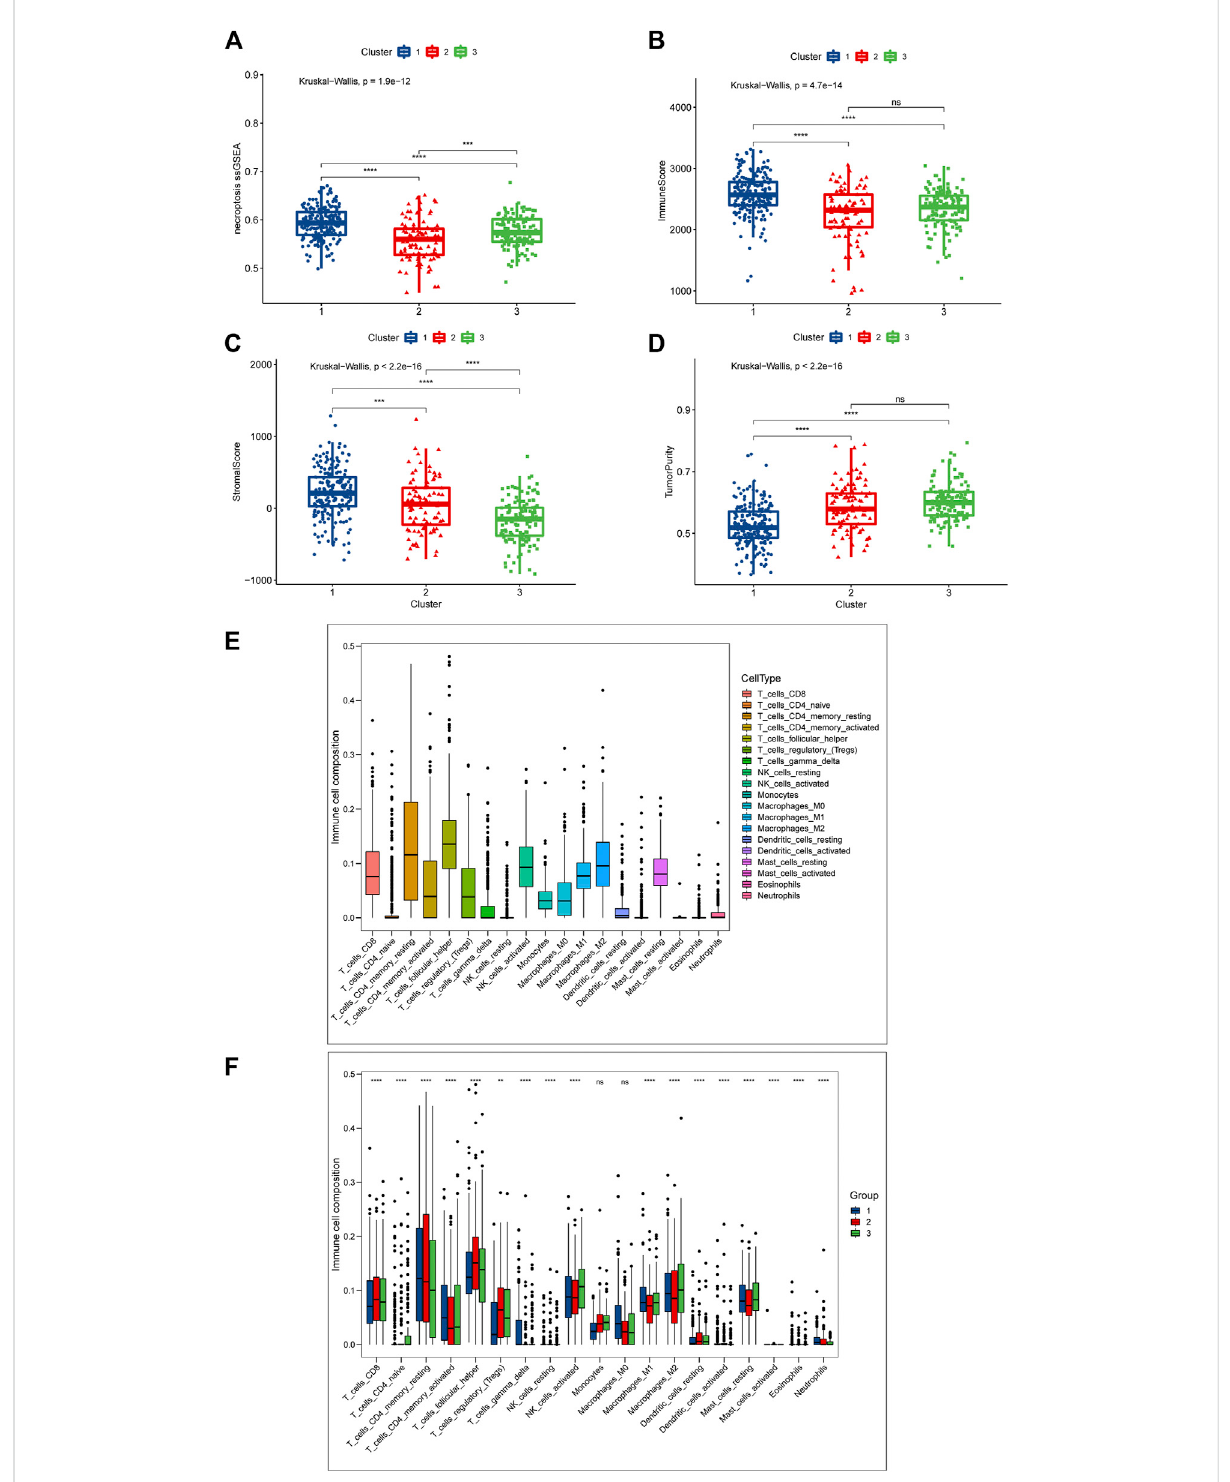
FIGURE 3 Differences in TME between the three necroptosis-related clusters (Cluster 1, Cluster 2 and Cluster 3). (A) Differences in necroptosis scores between the three clusters. (B) Differences in immune score. (C) Differences in stromal score between the three clusters; (D) Differences in tumor puritybetweenthethreeclusters. (E,F) Cibersortwasusedtoassessthein fi ltrationof19immunecelltypes. (E) Overallin fi ltrationof19immunecells. (F) Differencesin19immunecellsbetweenthethreeclusters.Nsmeans “ notstatisticallysigni fi cant ” ;* p < 0.05;** p < 0.01;*** p < 0.001;**** p < 0.0001 (all signi fi cance designations that appear in this paper are minor